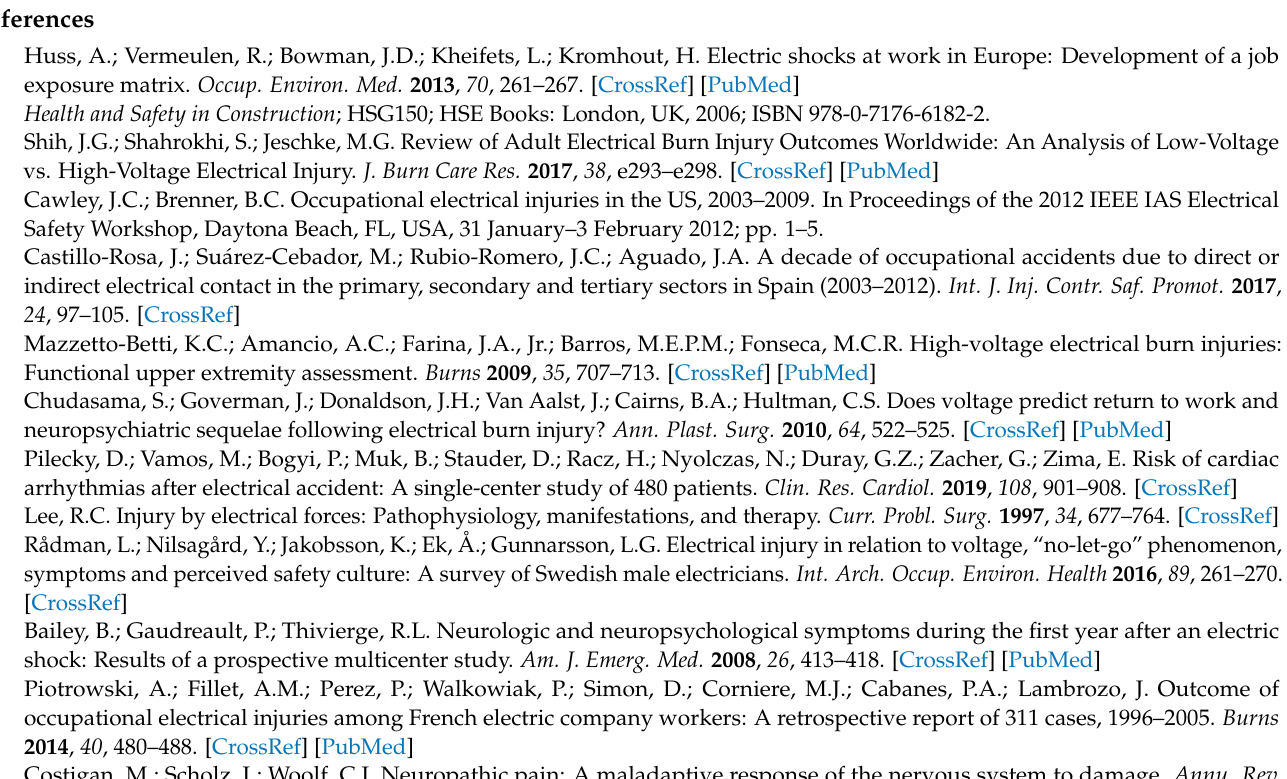
mentary Table S3: Individual results for patient’s sensory neurography; Supplementary Table S4: Demographic and clinical characteristics of